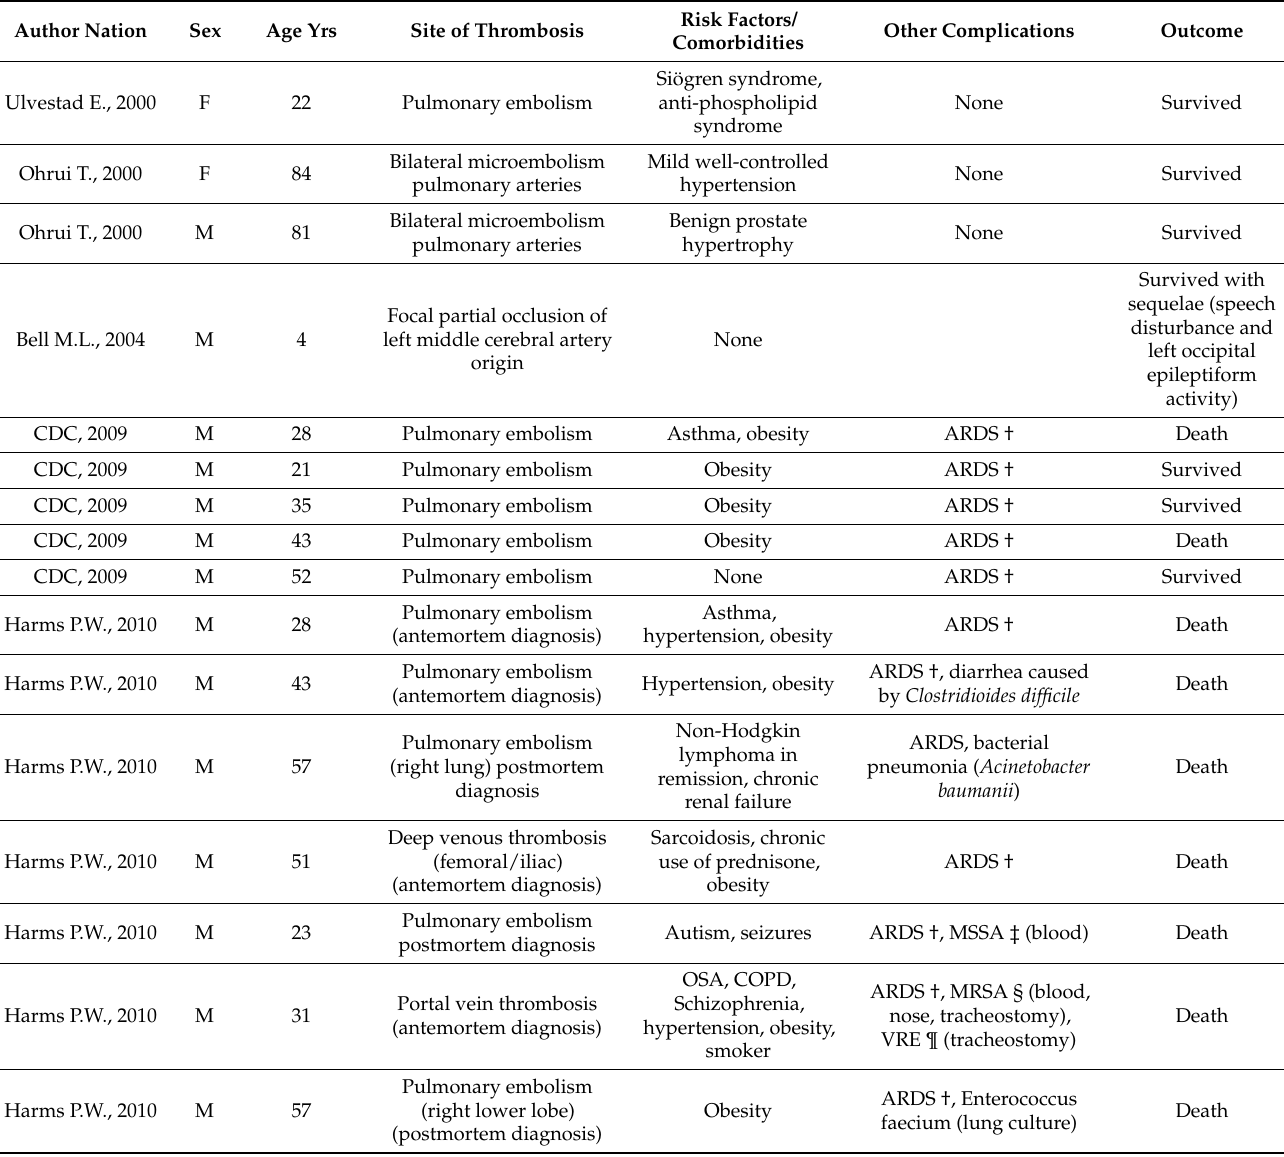
Table 1. Epidemiological and clinical characteristics, complications, and outcomes of study